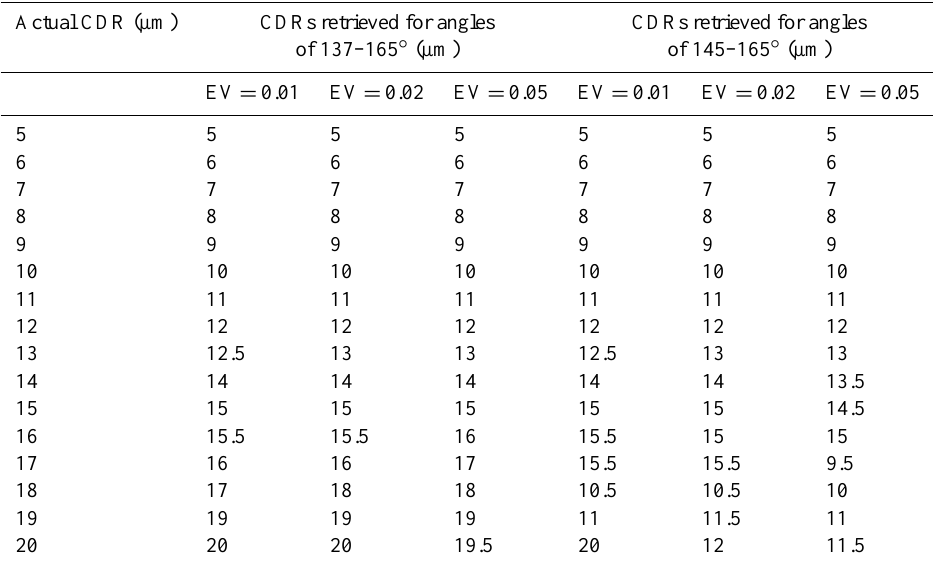
Table 5. Comparisons between CDRs estimated using POLDER-like measurements for scattering angle ranges of 137–165 ◦ and 145–165 ◦ , respectively. The retrievals were applied using 40 measurements at a wavelength of 865nm. The actual EVs used include 0.01, 0.02, and 0.05. Actual CDR (µm) CDRs retrieved for angles CDRs retrieved for angles of 137–165 ◦ (µm) EV =